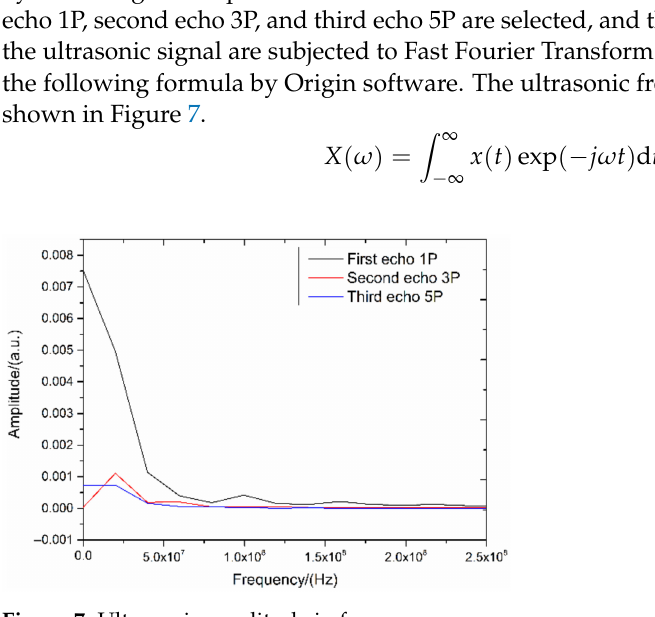
Figure 7. Ultrasonic amplitude in frequency.